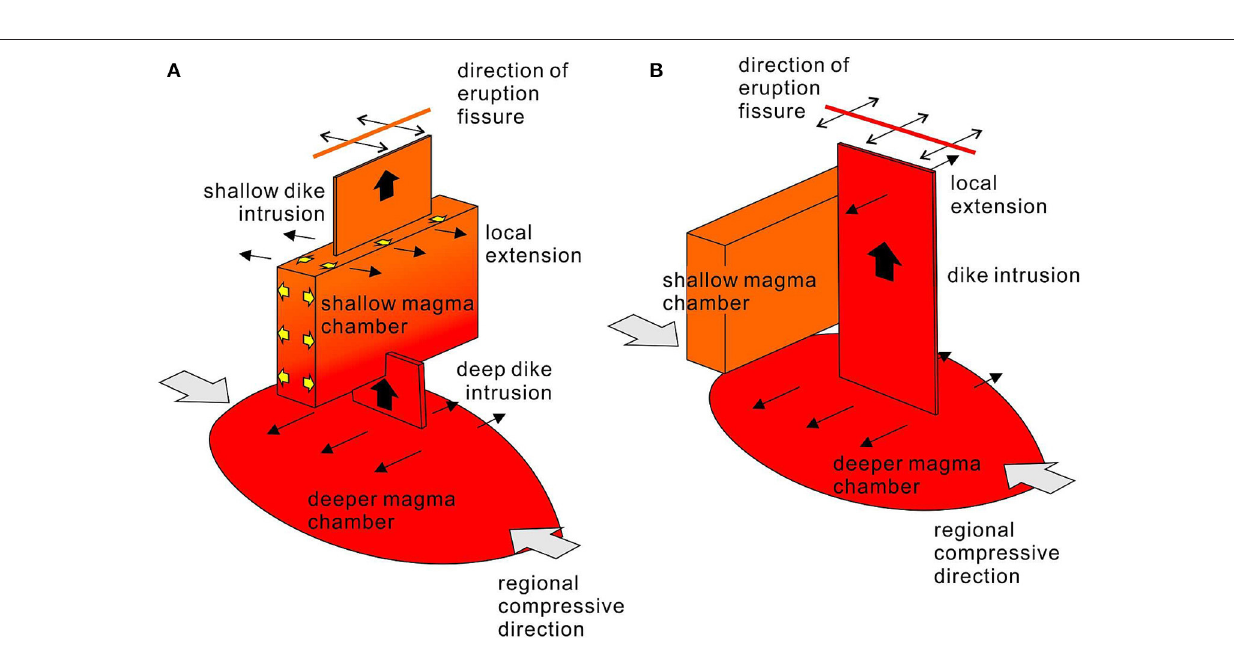
FIGURE 5 | Schematic model of the magma plumbing system of Miyakejima. (A) A basaltic dike extending from the from the deep-seated basaltic magma chamber injected into the shallow magma chamber filled with andesitic magma. Injection causes magma mixing within the shallow chamber and a dike with hybrid magma propagates from the shallow magma chamber. Injection also causes the rapid increase of the internal magma pressure in the shallow magma chamber to a local stress field around the shallow chamber. Orientation of the dike from the shallow magma chamber is mainly controlled by the local stress field generated by the pressurized shallow magma chamber. (B) A basaltic dike propagates directly from the deep-seated magma chamber without intersecting the shallow magma chamber. The orientation of the eruption fissure is mainly controlled by the regional stress